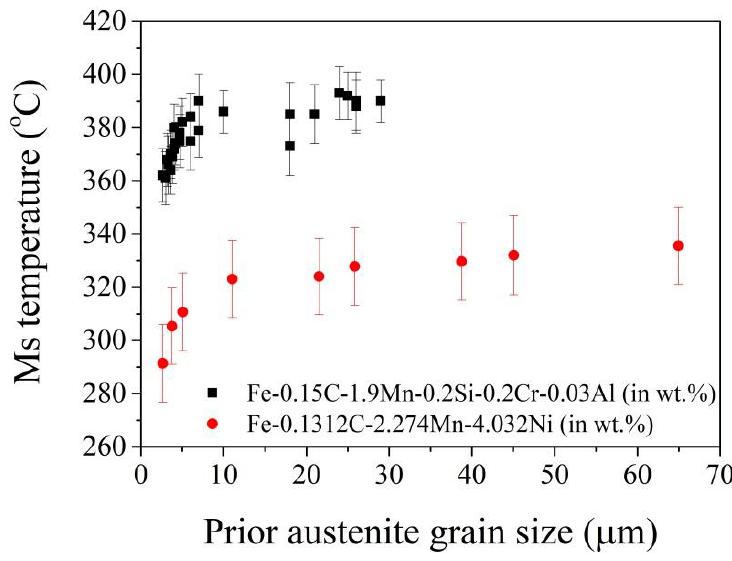
Figure 3. Correlation between prior austenite grain size and Ms temperature in steels with different chemical compositions [61,67].